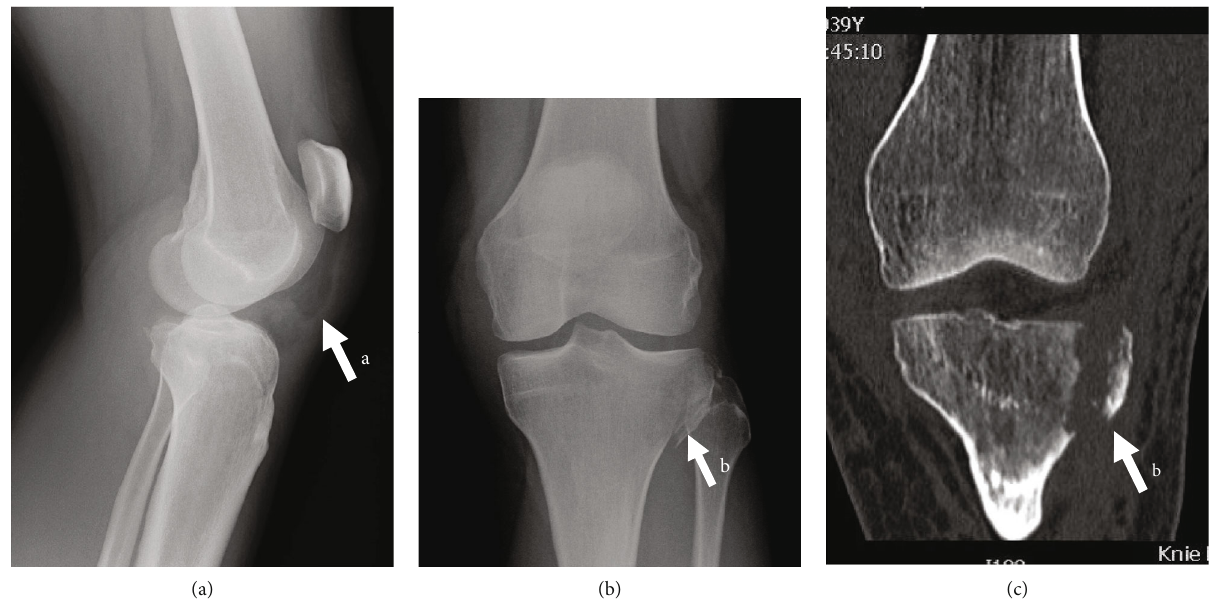
Figure 1: Preoperative X-rays: anterior-posterior (a), lateral (b), and coronal (c) view CT. Note the patella alta with a Caton Deschamps index of 1.5 (A) as an indirect sign of the PT rupture, as well as tibial plateau fracture